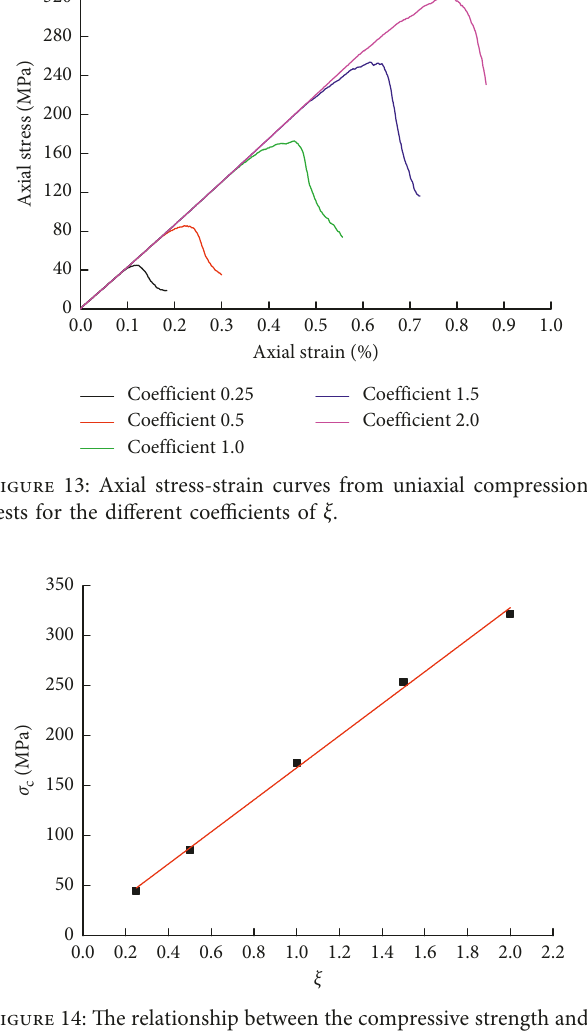
Figure 14: The relationship between the compressive strength and the strength coefficient ξ .